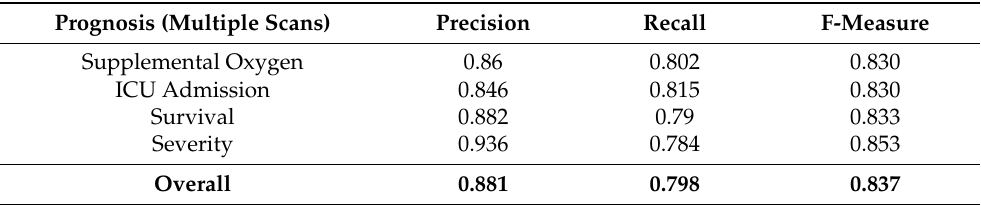
Table 4. Prediction performance of the proposed method using multiple scans per patient (both datasets). Prognosis (Multiple Scans) Precision Recall F-Measure Supplemental Oxygen